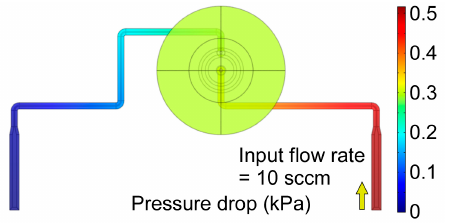
Figure 6. The pressure distribution along the fluidic path of the middle valve of the microvalve module.